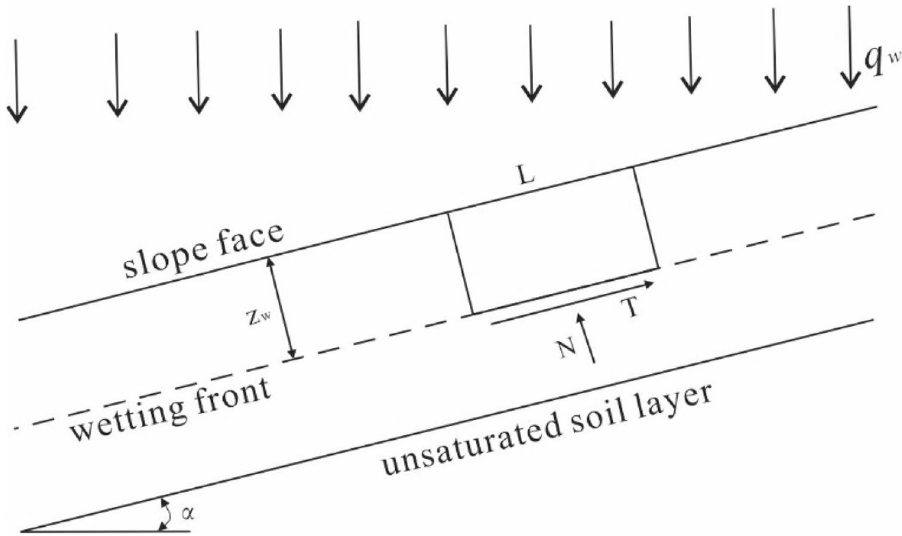
Figure 3. Schematic diagram of stability analysis of infinite slope under